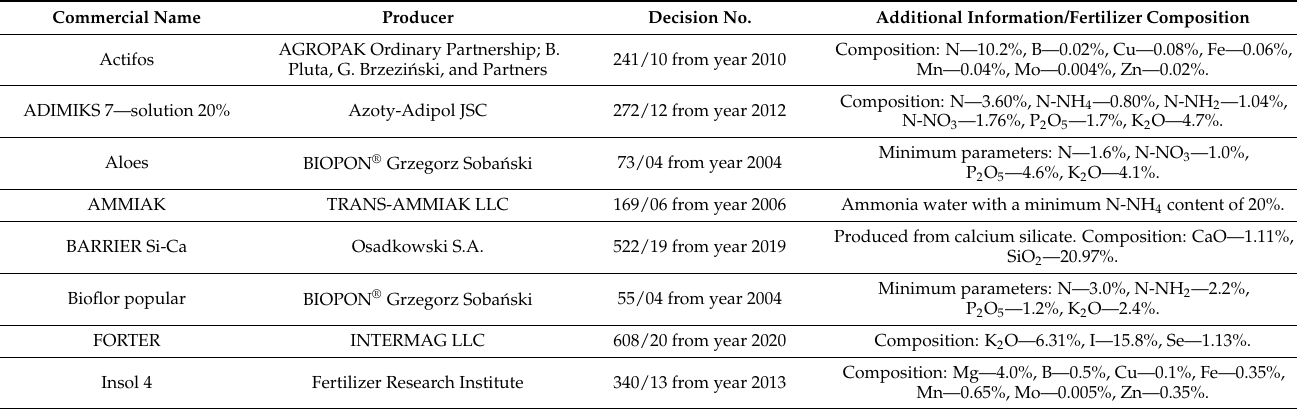
Table 8. Selected mineral fertilizers in liquid form (authors’ own elaboration based on